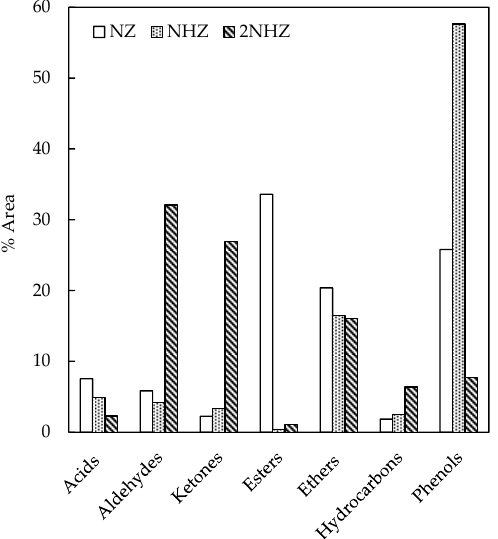
Figure 2. Primary chemical composition of bio-oil samples. Experiment Conditions: Pyrolysis Temp: 723 K; Cat. / Oak ratio: 4; Flow 120 ml · min − 1 ; Ramp rate 10 K · min − 1 .